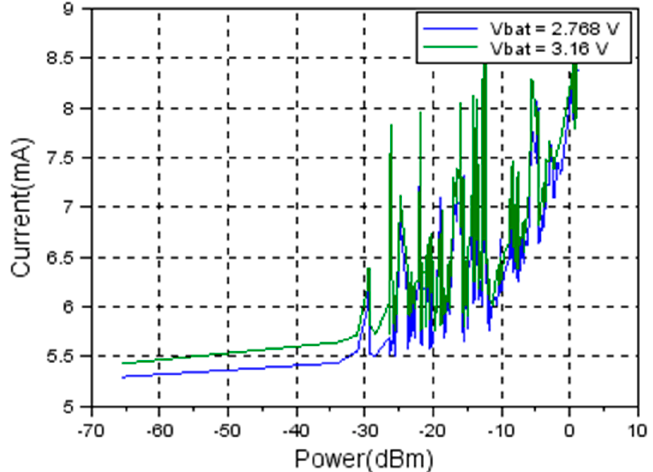
Figure 12. Current vs. transmission power. Comparison between fully charged batteries and discharged batteries.